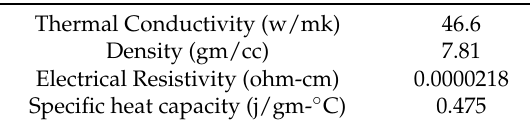
Table 2. Mechanical properties of EN 31 Tool Steel.